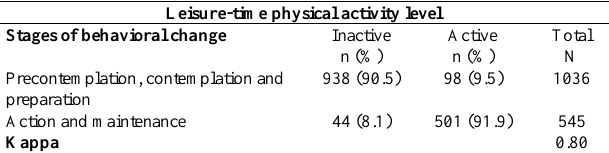
Table 1. Concordance between Stages of Behavior Change Questionnaire (SBCQ) and International Physical Activity Questionnaire (IPAQ). Overall